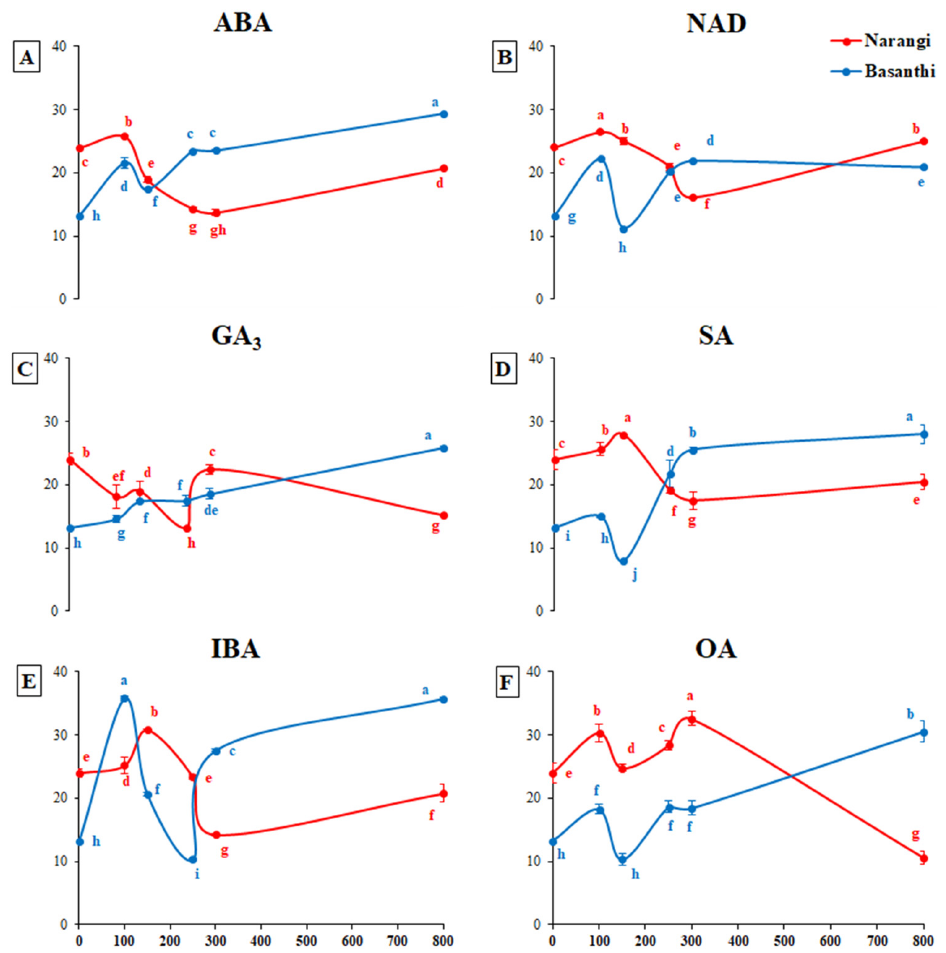
Figure 7. The DPPH free radical scavenging activity (%) of two cultivars of marigold (“Pusa Narangi Gainda” and “Pusa Basanthi Gainda”) as affected by different doses of (mg ∙ L − 1 ) ABA ( A ); NAD ( B ); GA 3 ( C ); SA ( D ); IBA ( E ) and OA ( F ). Same letters indicate non ‐ significant difference among treatments under Fisher’s least significant difference test ( p ≤ 0.05 ). Vertical bars indicate average ± standard error (three replications, under bi ‐ factorial CRD).